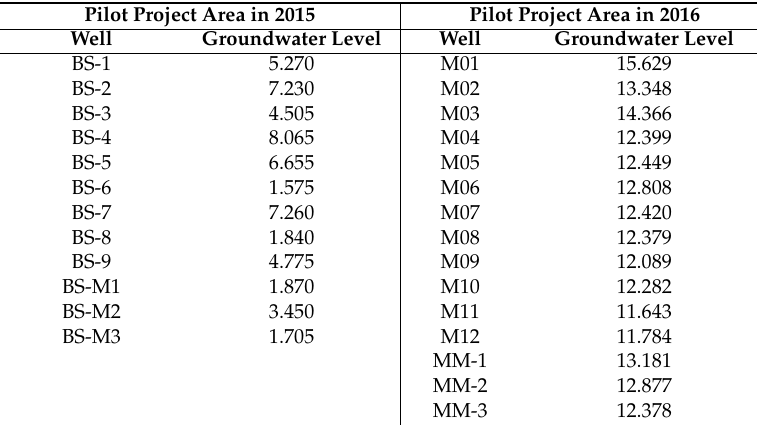
Table 12. Groundwater level data input for groundwater modeling (GL-, m).